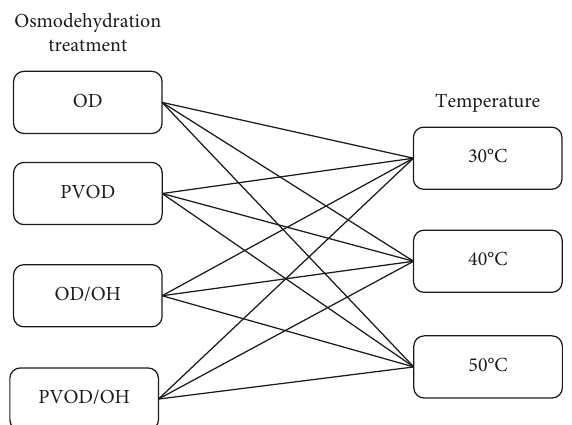
Figure 1: Experimental schema. Osmodehydrated treatments with cryoconcentrated pomegranate juice (47 ° Brix) and temperatures. PVOD: osmotic dehydration with pulsed vacuum; OH: ohmic heating (OD/OH and PVOD/OH) at